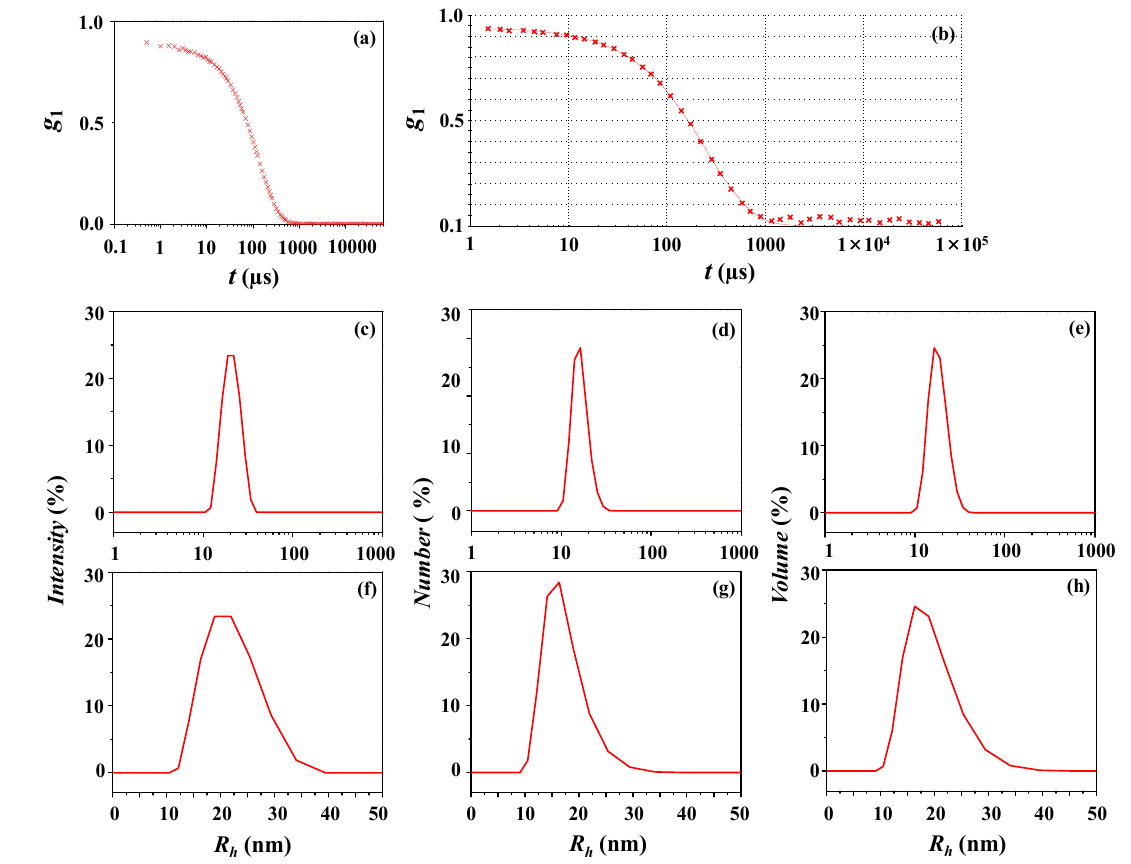
Figure 2. Dynamic light scattering (DLS) data analysis of the c -PDGE- b -PTEGGE micelle formed in an ethanol/water (75/25 in wt/wt ) mixture: ( a ) autocorrelation function profile measured at 25 ° C; ( b ) data analysis result, where the symbols are the measured data and the red solid line was obtained by fitting the data using the Zetasizer program; ( c,f ) intensity-weighted radius distribution obtained by the data analysis; ( d , g ) number-weighted radius distribution; ( e,h ) volume-weighted radius distribution.